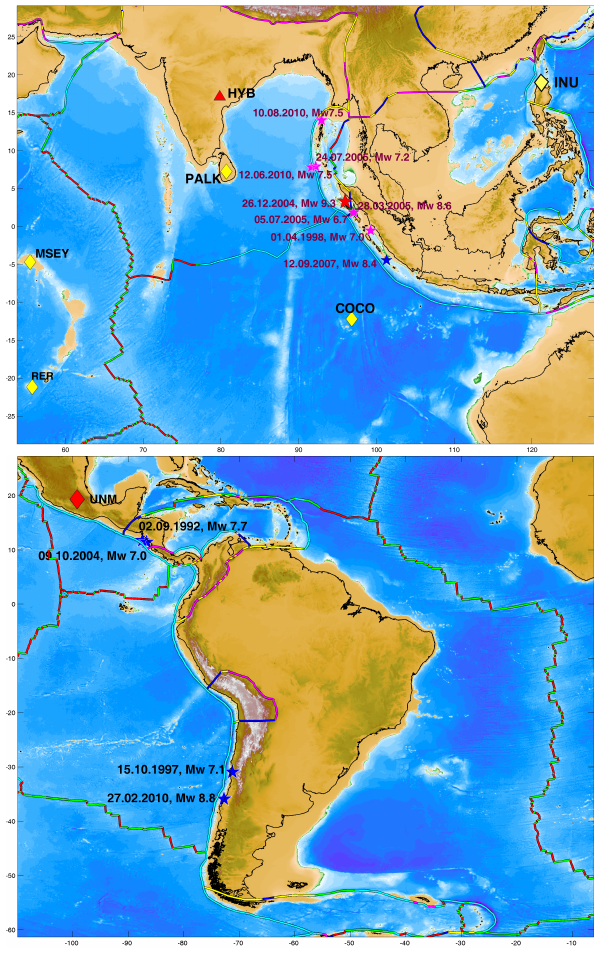
Fig. 1. The epicenter and seismic stations of IRIS (diamond sym- bol) and Geoscope (triangle symbol) used in our analysis.